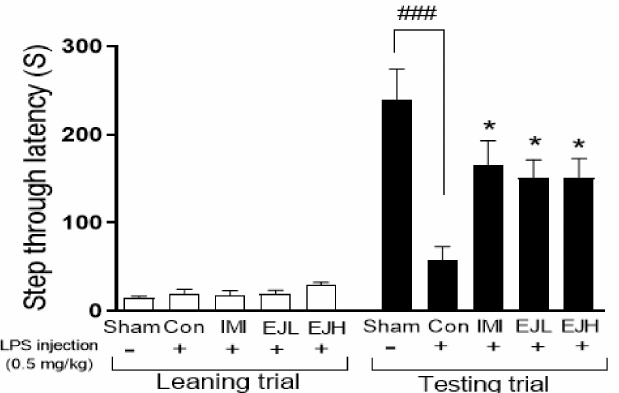
Figure 4. E ff ect of EJE on memory in LPS-induced depressive mice. EJ extract significantly improved LPS-induced memory loss in mice, indicated through an increased step through latency time (s). Results are presented as mean ± SEM. EJE, E. japonicum extract; LPS, lipopolysaccharide; Con, control; IMI, imipramine 30 mg / kg; EJL, EJE 100 mg / kg; EJH, EJE 300 mg / kg. * p < 0.05 versus the LPS-injected Con; ### p < 0.001 versus the